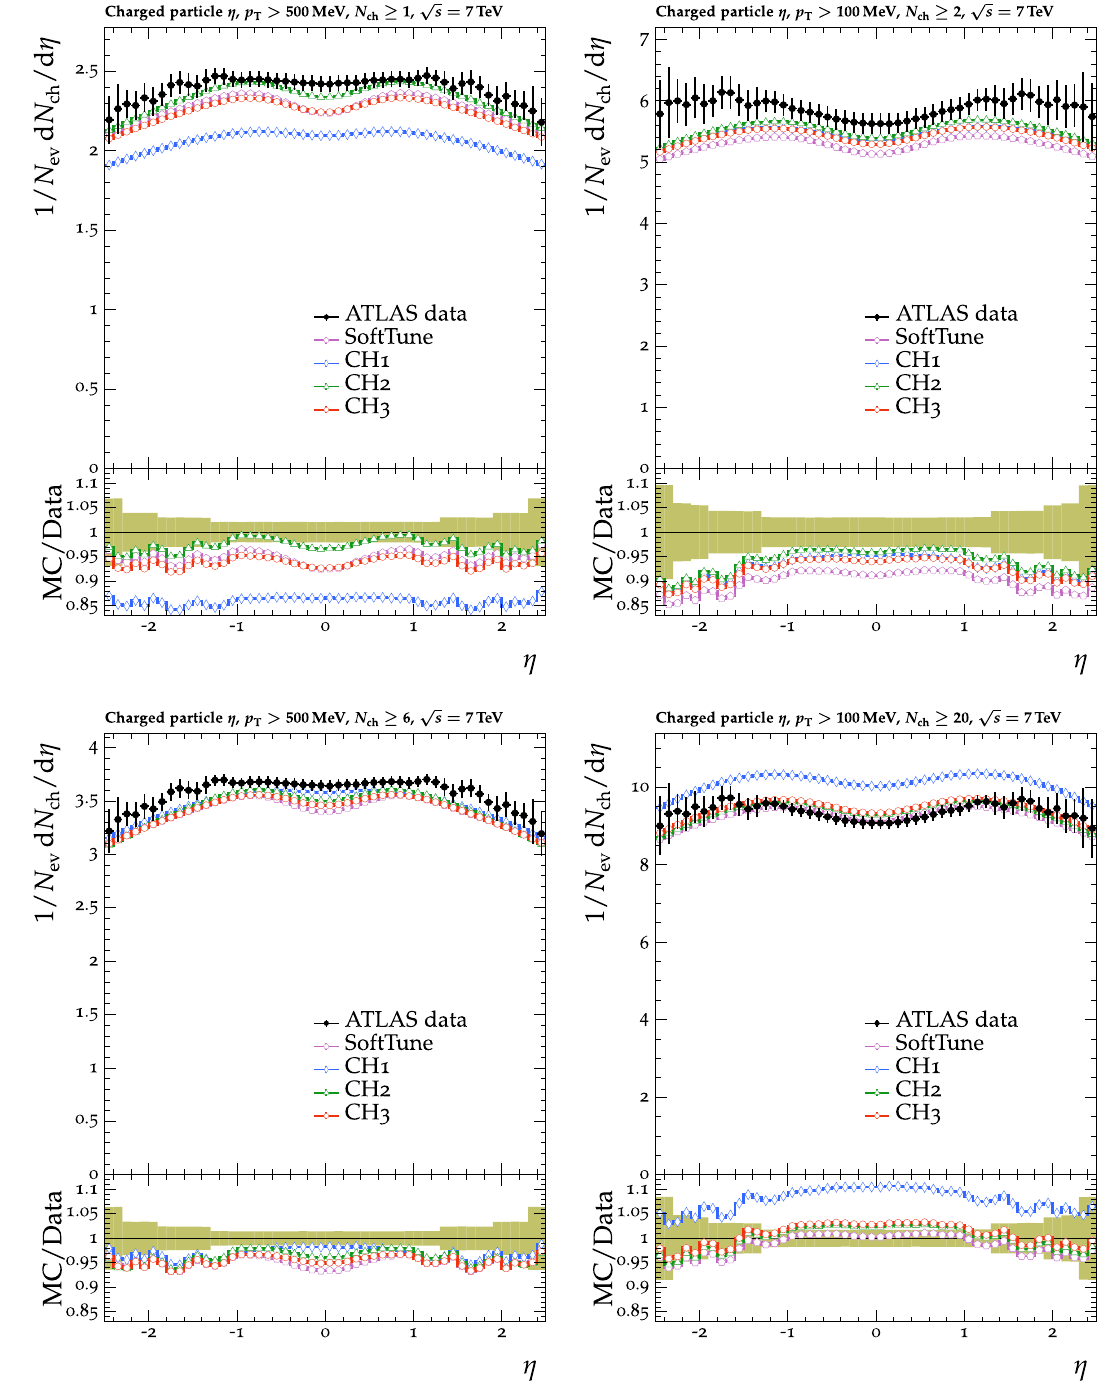
Fig. 21 Normalized plots [17] for the pseudorapidity of charged par- ticles for N ch ≥ 1 (upper left), and N ch ≥ 6 (lower left), for charged particles with p T > 500MeV. The figure on the upper right shows a similar distribution for N ch ≥ 2, and the lower right for N ch ≥ 20, where the charged particles have p T > 100MeV. ATLAS MB data